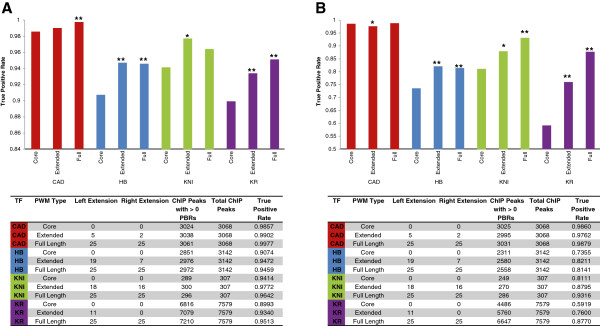
Position Weight Matrix extension enables high fidelity identification of Predicted Binding Regions in ChIP-seq peaks. Three different PWMs were constructed for CAD (red), HB (blue), KNI (green), and KR (purple) respectively, corresponding to; the core PWM-PBR (core), a region encompassing the core PBR and all statistically significant flanking sequence context-dependent biases (extended), and the core with 25 bp of flanking sequence on each side (full). For each individual PWM, PATSER was run on filtered ChIP-seq peaks using a low stringency (A, corresponding to the 25th percentile) or high stringency (B, corresponding to the 50th percentile) primary cutoff and then a secondary cutoff score corresponding to the 0th percentile (see Methods for full details). Charts depict the true positive rate (defined as the number of ChIP-seq peaks for which the PWM predicts > 0 binding regions divided by the total number of ChIP-seq peaks). Statistical significance of divergence in true positive rate of expanded PWMs from the corresponding core type PWM is indicated with asterisks (Two-tailed Fisher exact test, * denotes P-value < 0.05, ** denotes P-value < 0.0001).